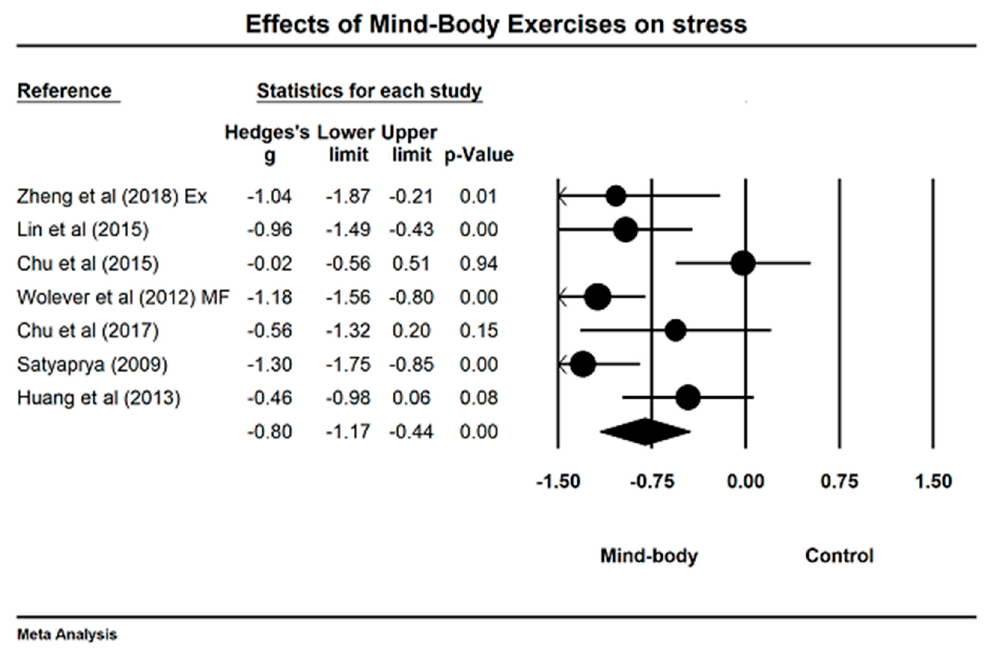
Figure 8. Effects of mind–body exercises on stress reduction (Ex = exercise control, MF = mindfulness control).